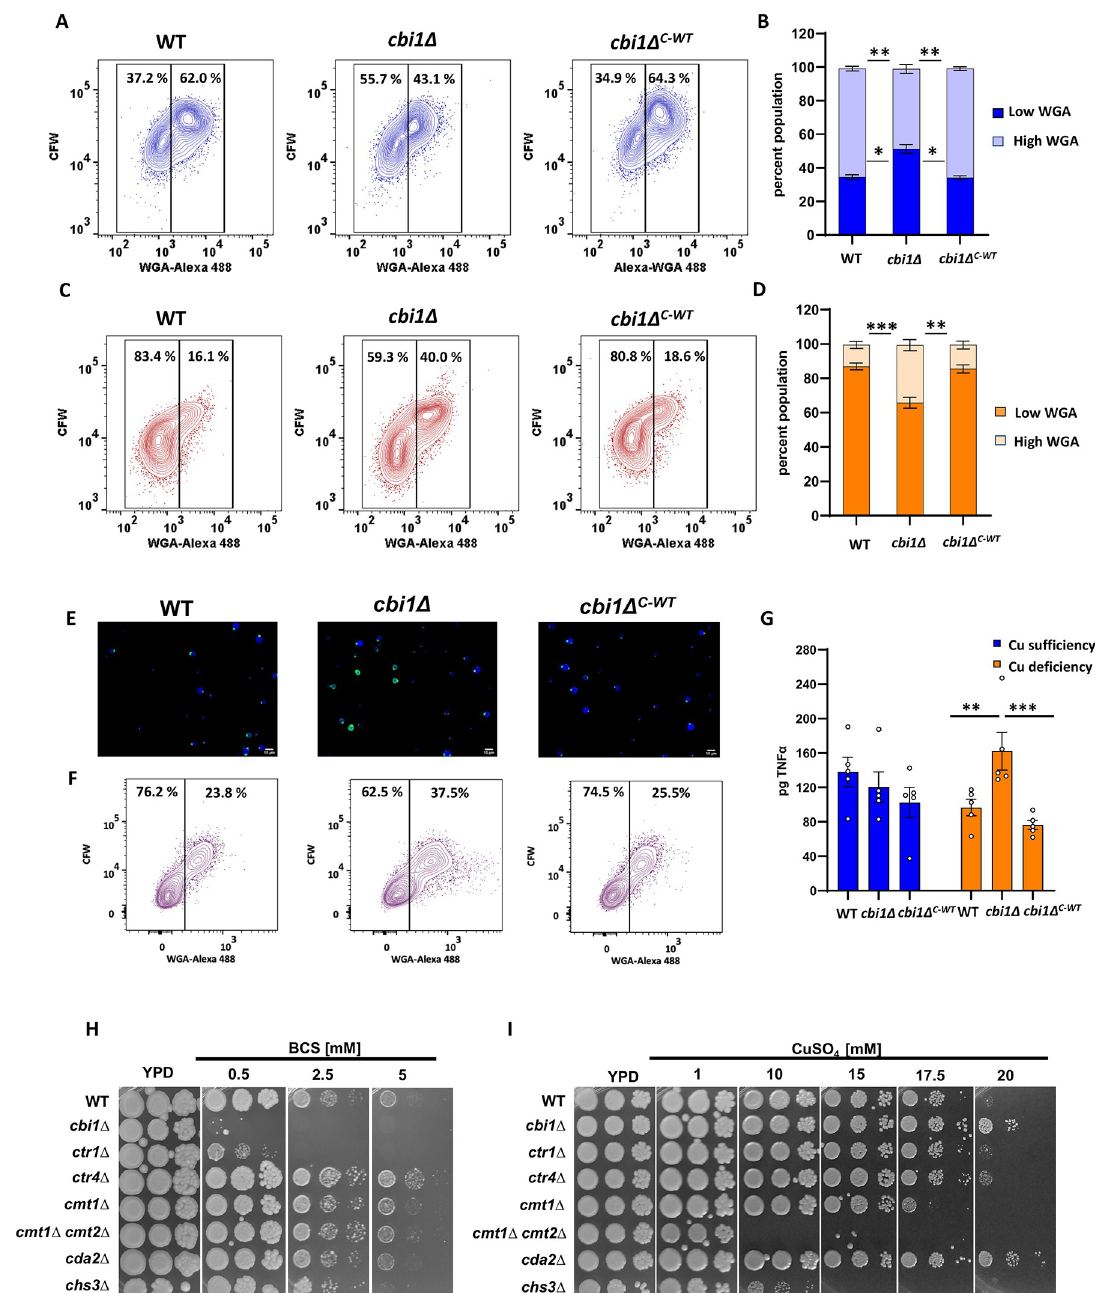
Fig 5. Cbi1 depletion effects chitin architecture during copper deficiency and host stress. (A)-(D) The WT, cbi1 Δ mutant, and cbi1 Δ C-WT complemented strains were incubated for 24h in YPD+ 10 uM CuSO4 (copper sufficiency) or YPD +250 μ M BCS (copper deficiency), harvested, and double stained with CFW and WGA-Alexa 488. Stained cells were analyzed using a FACS Canto A Analyzer, and data were analyzed using Flow Jo. Representative data indicating percentage of total cells staining as “High WGA” (increased exposed chitin/chitosan) after incubation in copper-sufficiency (A) or copper-deficiency (C) . Quantification of three independent experiments for copper-sufficiency (B) or copper-deficiency (D) conditions. A 2-way ANOVA was performed from log transformed data using GraphPad Prism. (E)-(F) Cell wall analysis was performed for the WT, cbi1 Δ mutant, and cbi1 Δ C-WT complemented strains after incubation for 24h in CO 2 -independent medium at 37˚C. Cells were analyzed microscopically using WGA-Alexa 488 staining (E), or by FACS analysis for High WGA cells per above (F) . (G) Macrophage activation assay upon infection with copper sufficient or deficient WT, cbi1 Δ and cbi1 Δ C-WT complemented cells. BMMs were harvested from A/J mice and co-incubated with Cn cells at an MOI of 10:1 (Cn:BMMs), followed by an ELISA-based quantification of TNF- α (pg) in the supernatant. Presented is the mean +/- SEM of 5